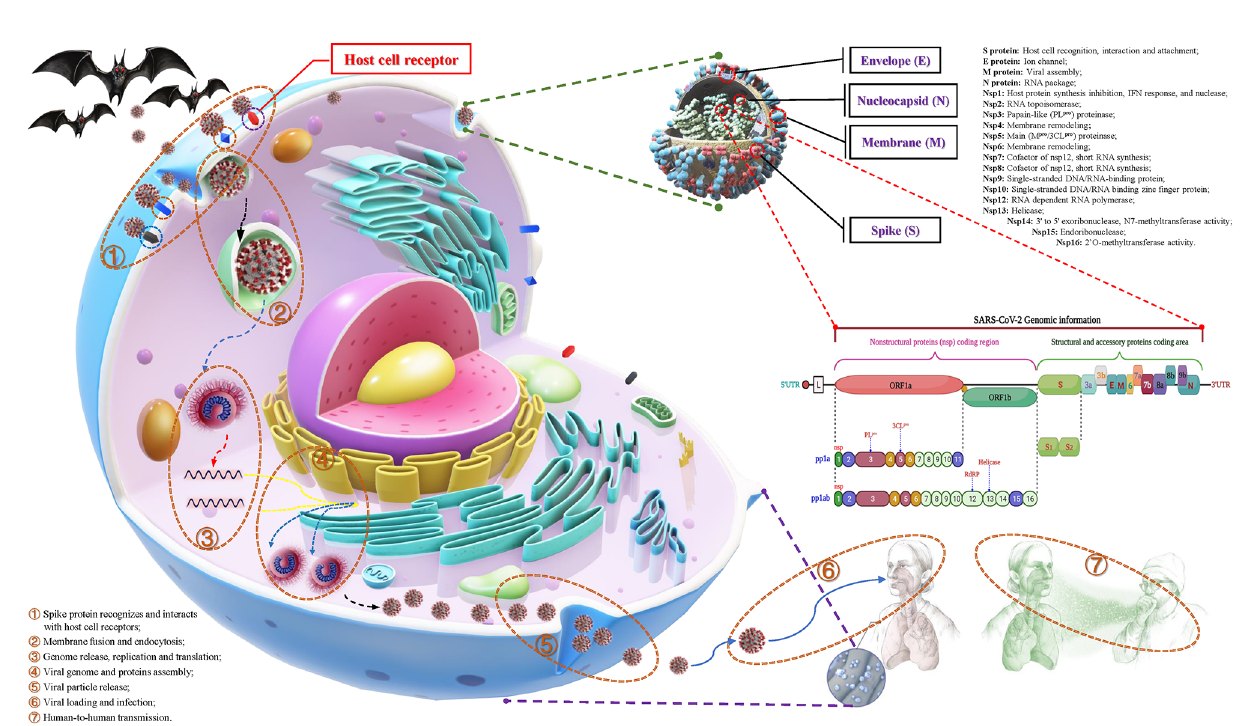
FIGURE 2 | The structural features, potential functions and transmission process of SARS-CoV-2. Structurally, the outer side of SARS-CoV-2 is surrounded by a capsid, which is mainly composed of spike (S), membrane (M), and envelope (E) proteins, while the nucleocapsid (N) protein is accompanied by the genome. The genomic structure of SARS-CoV-2 is based on a single-stranded positive-stranded RNA, which contains a 5 ’ -methylated cap and a 3 ’ -polyadenylic acid tail, arranged in the following order: 5 ’ -end; nonstructural protein (nsp) coding region [open reading frame (ORF1a/b)]; structure and accessory protein coding regions such as S, E, M, N and 3a, 3b, 6, 7a, 7b, 8a, 8b, 9b. Among them, the open reading frame (ORF) 1a/b is responsible for encoding a variety of nonstructural proteins, mainly RNA-dependent RNA polymerase (RdRP), papain-like protease (PL pro ) and 3C-like protease (3CL pro ). The putative functions of these proteins are mentioned in the fi gure. During the infection process, SARS-CoV-2 recognizes and interacts with host cell surface receptors and enters the host cell through membrane fusion and endocytosis. After entering the host cell, SARS-CoV-2 releases its genome and translates a large number of nsps, including RdRP, PL pro and 3CL pro . Under the action of these enzymes, it synthesizes the new RNA genome and assembles to form virus particles, which are then released into the extracellular space through exocytosis. Uncontrolled replication promotes SARS-CoV-2 infection, leading to immune disorders and in fl ammatory cytokine storms and ultimately leading to damage to multiple organs, especially the